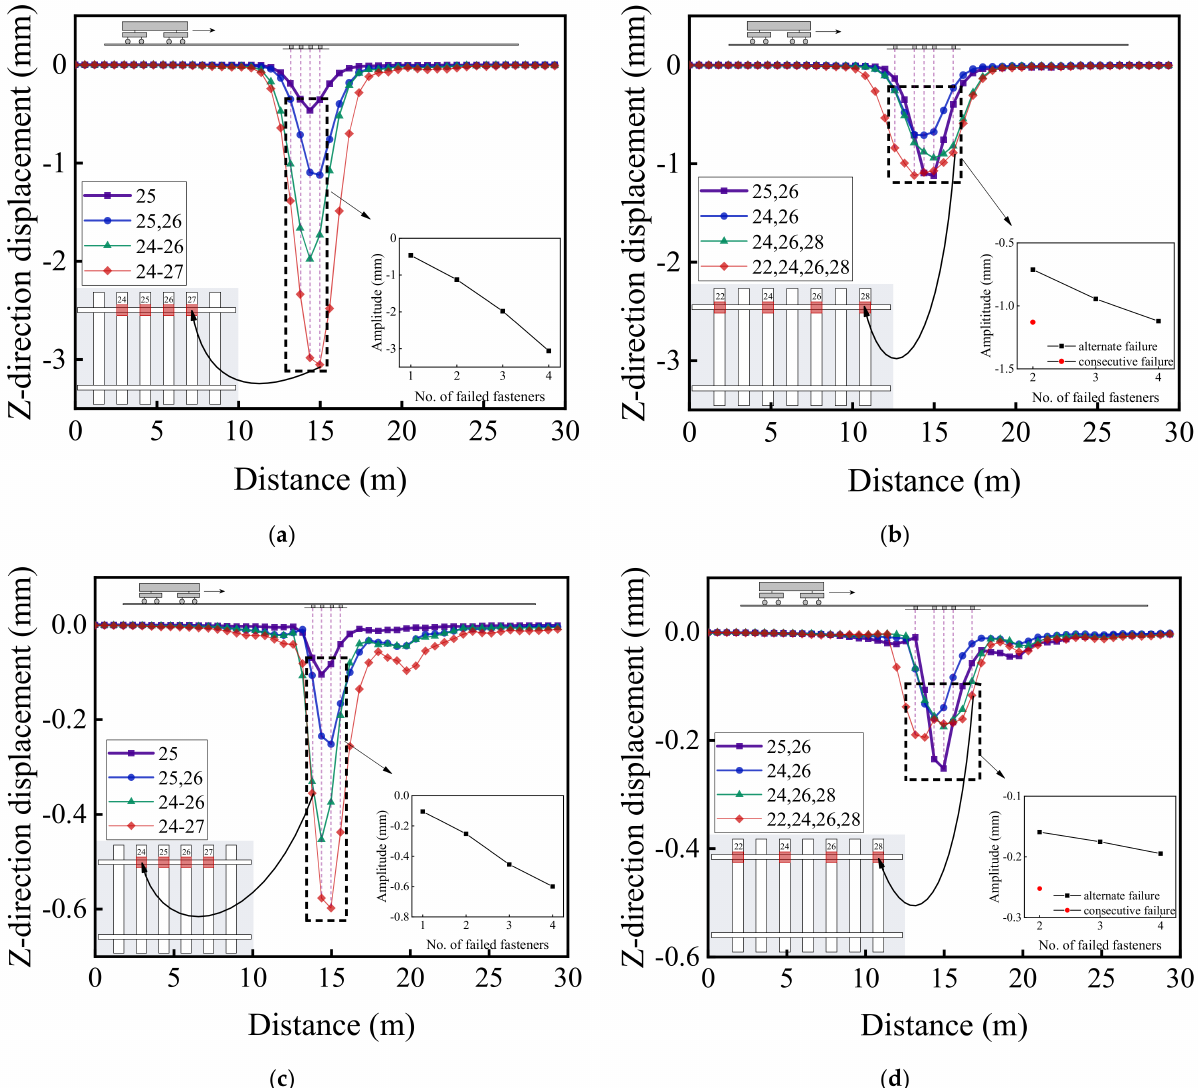
Figure 21. The longitudinal variations of vertical displacement responses (from No. 1 to No. 50 rail node) of ( a ) the rail at the side with consecutively failed fasteners, ( b ) the rail at the side with alternately failed fasteners, ( c ) the rail at the opposite side of consecutively failed fasteners, and ( d ) the rail at the opposite side of alternately failed